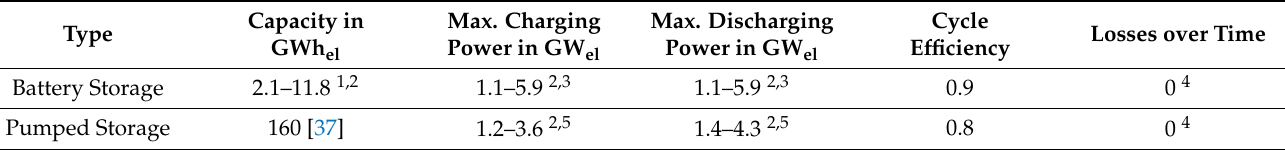
Table A12. Parameter of the used storages in the scenario